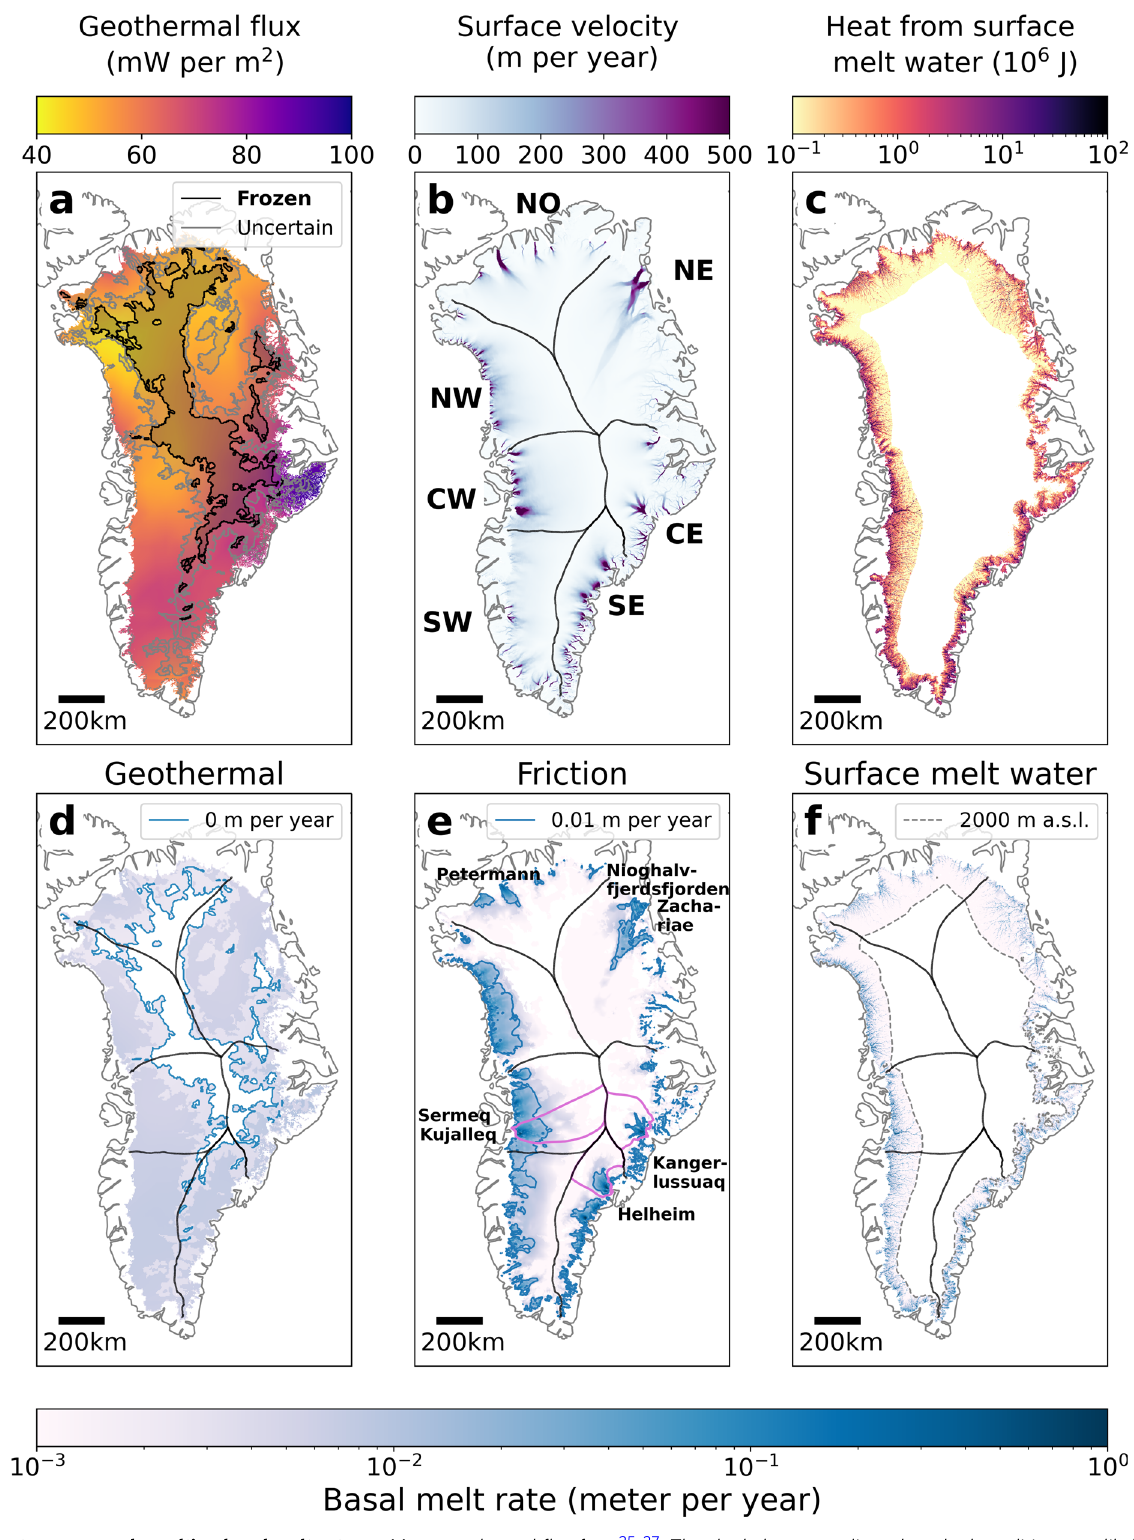
Fig. 1 Heat sources and resulting basal melt rates. a Mean geothermal fl ux from 25 – 27 . The shaded areas outline where bed conditions are likely frozen (black) or uncertain (grey) based on radar observations and numerical ice- fl ow models 28 . b Surface velocities from multi-year MEaSURES dataset 15 . c Heat generated by surface melt-water in fi ltration. d Basal melting from geothermal heating. Blue contours outline the 0 m per year extent. e Basal melting from frictional heating. Purple outlines show the glacial catchments of Sermeq Kujalleq, Kangerlussuaq and Helheim Glacier 55 . Blue contours outline the 10 − 2 m per year extent. f Basal melting from surface water heating. Dashed grey contours outline the 2000m above sea level elevation. d – f have the same logarithmic